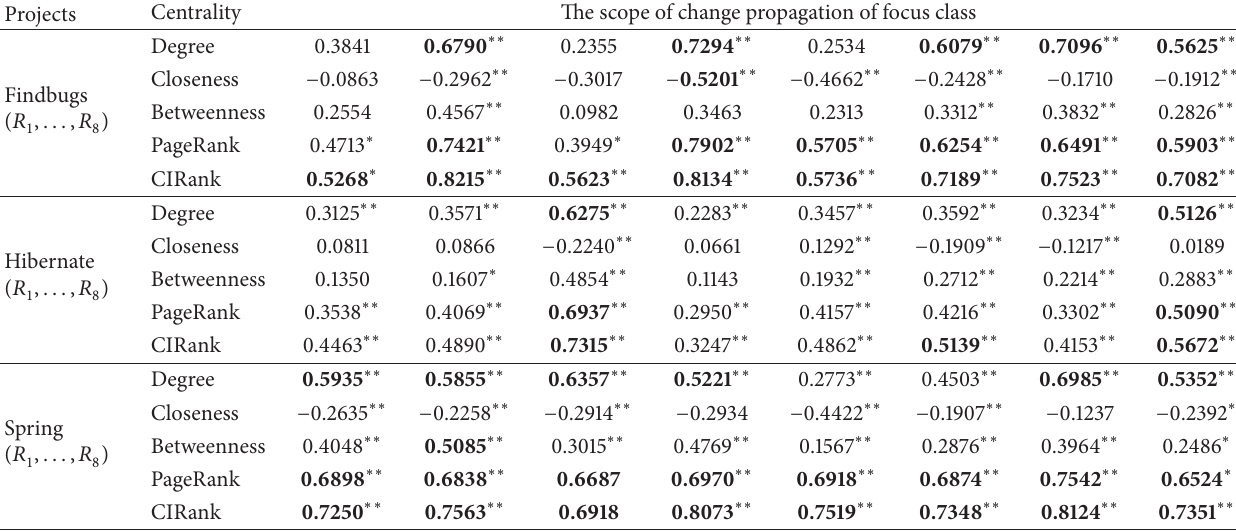
Table 3: Spearman’s coefficient for three subject projects.